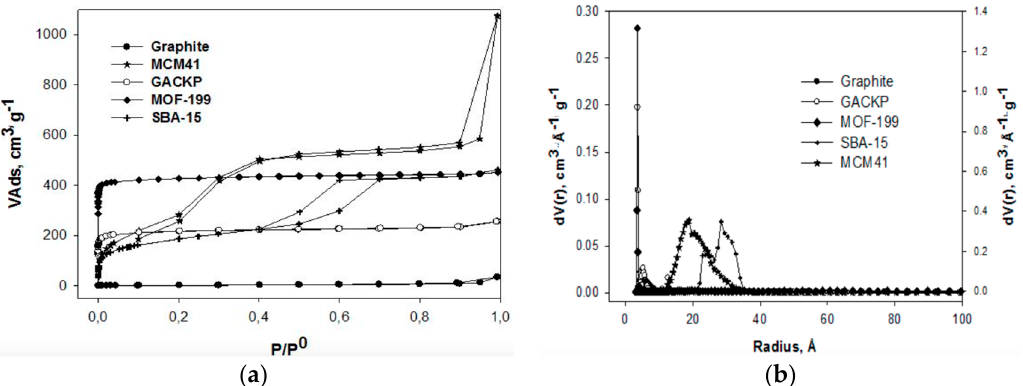
Figure 1. N 2 adsorption-desorption isotherms ( a ) and ( b ) pore size distributions by DFT models . Table 1. Textural parameters of all samples from the N 2 adsorption-desorption isotherm at − 196 °C . Samples